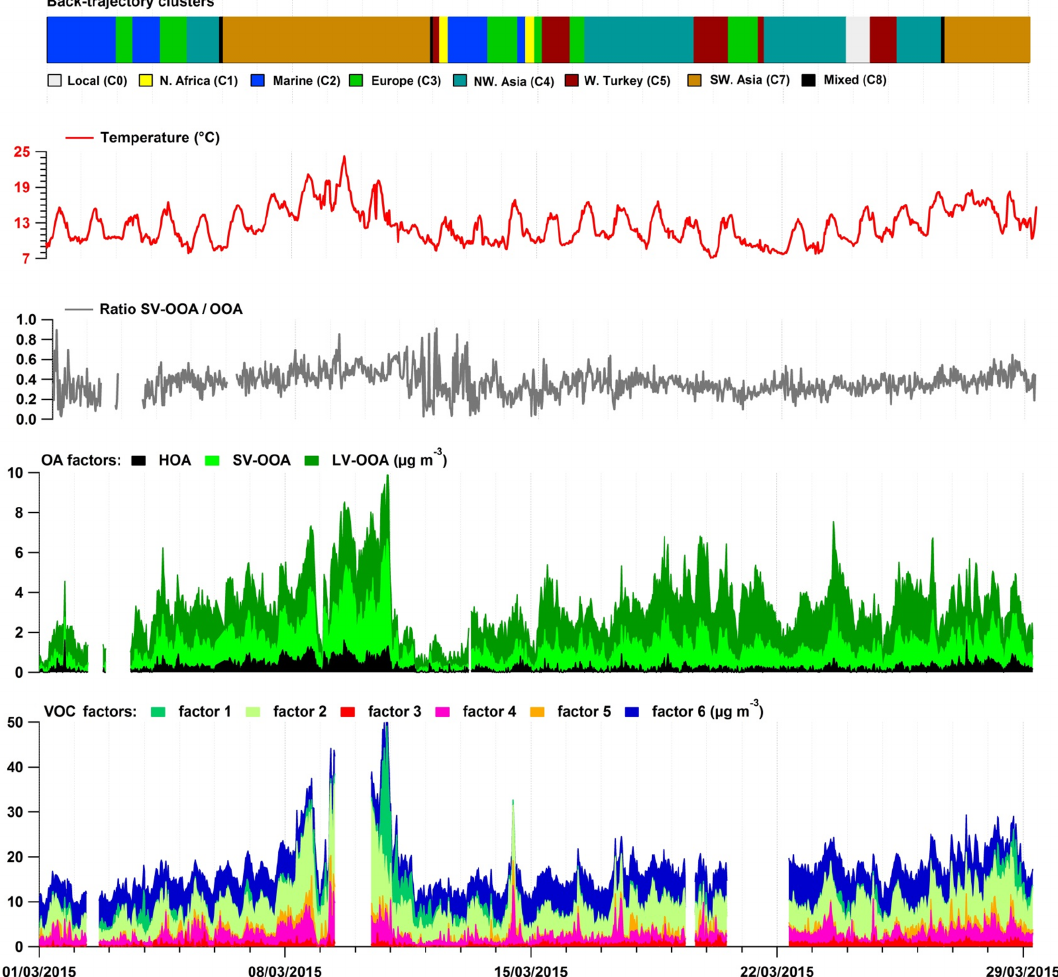
Figure 15. Accumulated time series of OA and VOC factor contribution; time series of temperature and air mass origin (C: cluster). VOC factors: factor 1 – biogenic source 1; factor 2 – biogenic source 2; factor 3 – short-lived combustion source; factor 4 – evaporative